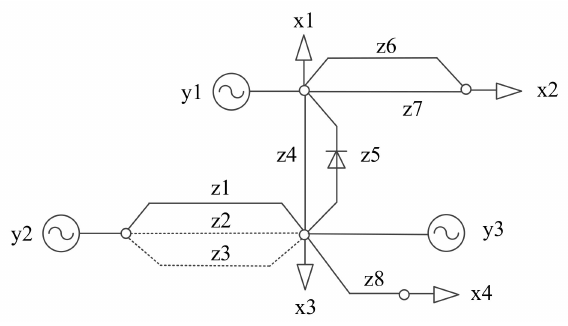
Figure 6. Five-bus test system. Table 3. Active power and transmission capacities of lines in the five-bus